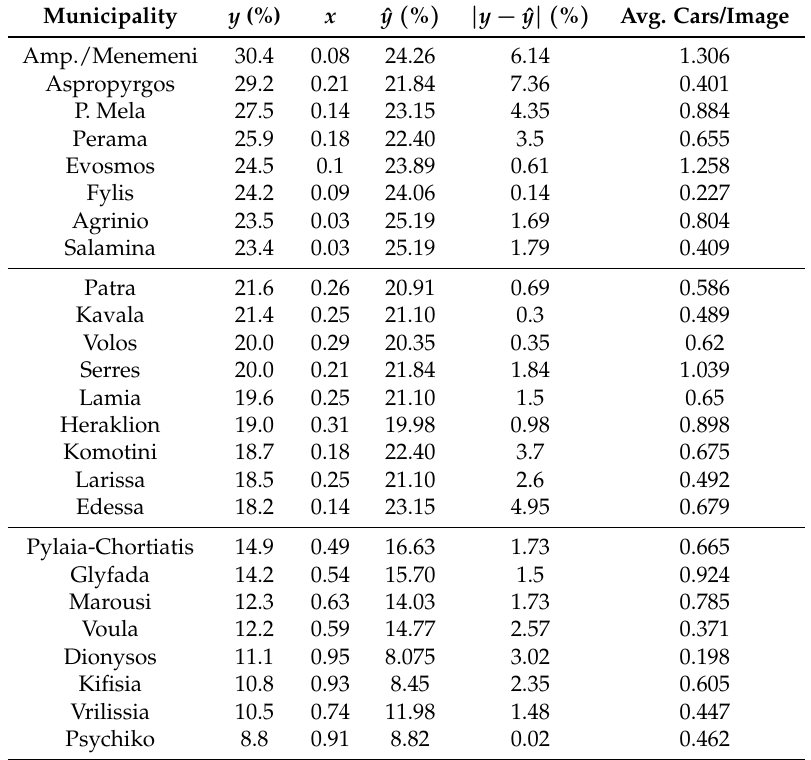
Table 2. The 25 municipalities used to create our linear model, as well as their unemployment rate ( y ), surrogate score ( x ), model prediction ( ˆ y ), and absolute error. Municipalities are grouped into high-medium-low unemployment rate, based on statistical authority data. The average cars per Google Street View (GSV) image is also shown (which, in this case, is not highly correlated with unemployment rate).